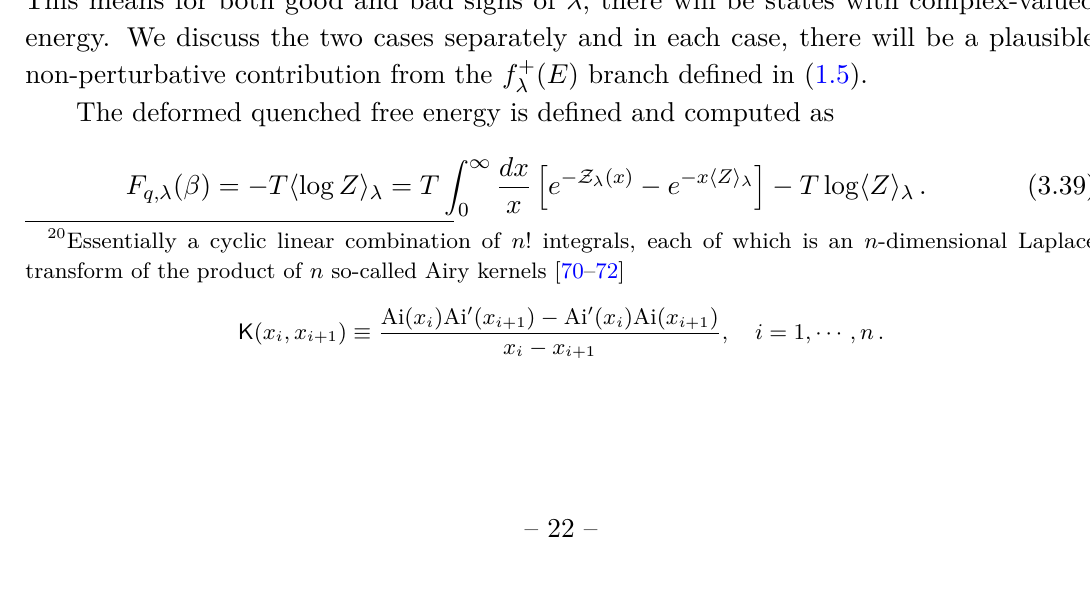
(cid:16) (cid:16) √ (cid:17)(cid:17) log 3 x, 1 √ with respect to x . One can clearly see this fraction T x 2 3 3 / 2 0 ’